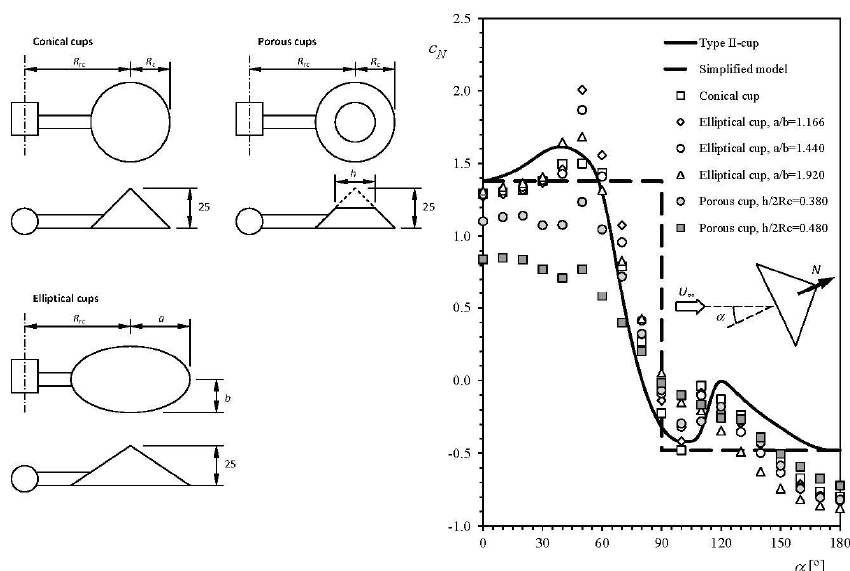
Figure 4. Normal-to-the-cup aerodynamic force coefficient, c N , regarding different cups: Brevoort & Joyner Type-II (conical) [25], conical, elliptical and porous [77] (see sketch on the left side, R c = 25 mm), plotted in relation to the wind direction with respect to the cup, α . The 2-cup analytical model simplification of the experimental results related to the Brevoort & Joyner Type-II cup, has been included as a dashed